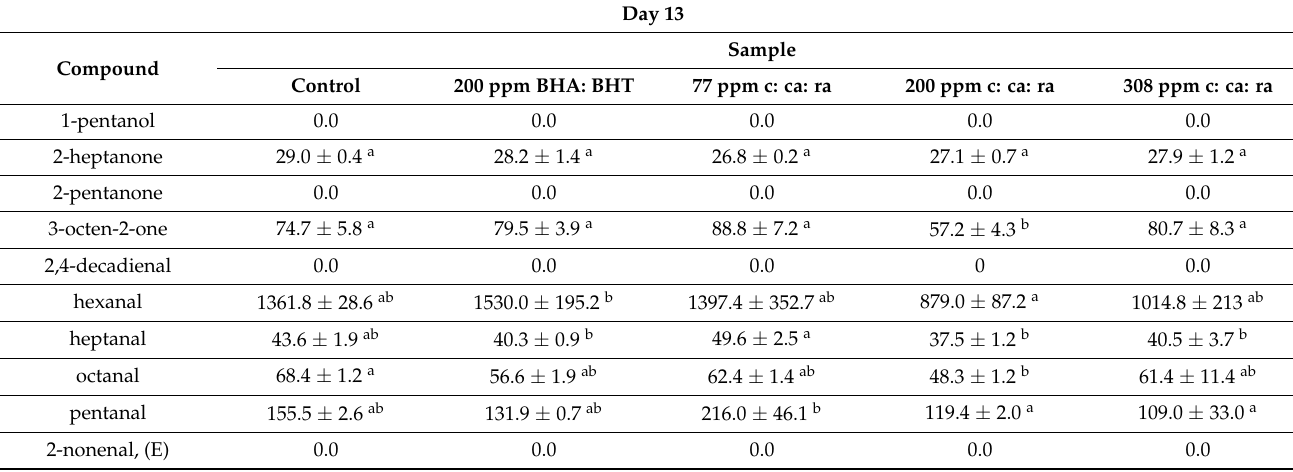
Table A6. Levels of volatile compounds ( µ g/kg of FFMP) as measured with HS-SPME-GC-MS analysis in FFMPs with or without antioxidants, after accelerated storage (40 ◦ C, RH 23%) for 13 days 1, 2, 3, 4